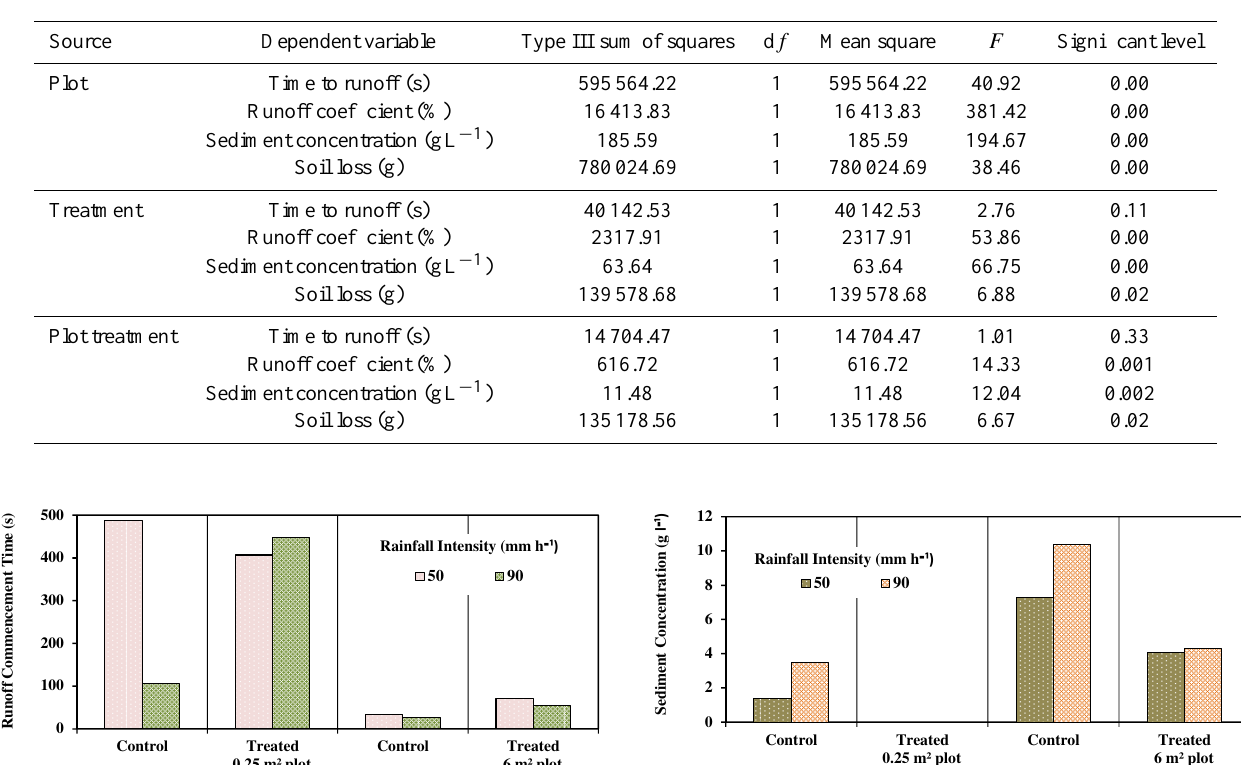
Table 5. Results of GLM test for plot size and conservation treatment effects on the quantitative characteristics of runoff and soil loss.